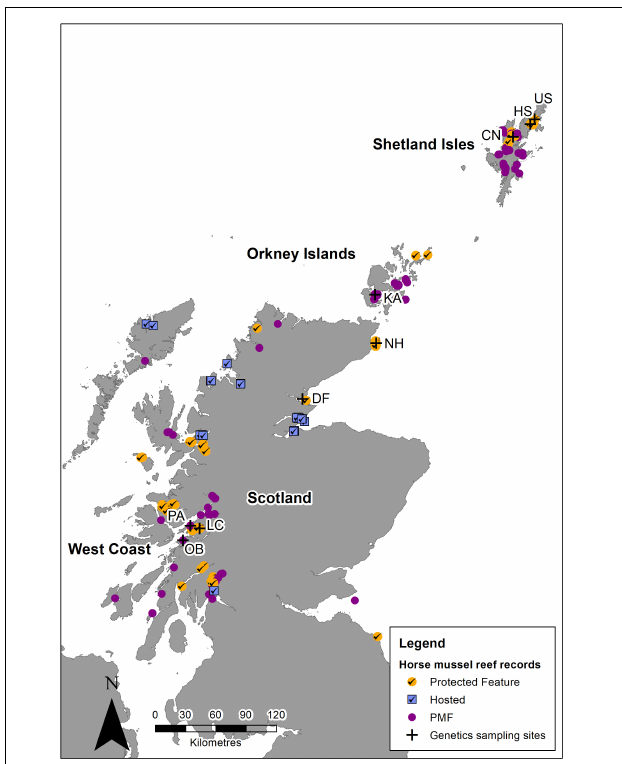
FIGURE 6 | Horse mussel ( M. modiolus ) reef records based on the Geodatabase for Marine Habitats and Species adjacent to Scotland Coastline (GeMS) showing records within protected areas where they are a designated feature (orange circle with tick), reefs that are hosted in closed area for which the presence of M. modiolus reefs was not the reason for designation (blue square with tick), and M. modiolus reef outside of protected areas and closed areas where they are a Priority Marine Feature (purple circle). Sites where samples were collected for genetic analysis also show (cross) for context. Crown © and database right (2021). Ordnance Survey License number